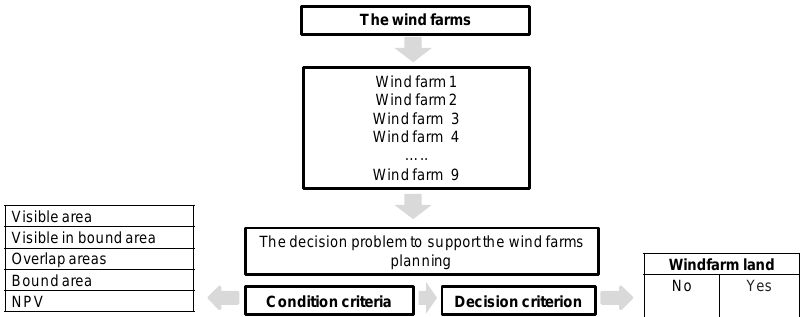
Figure 6. Decision-making problem to support planning the wind farm system.